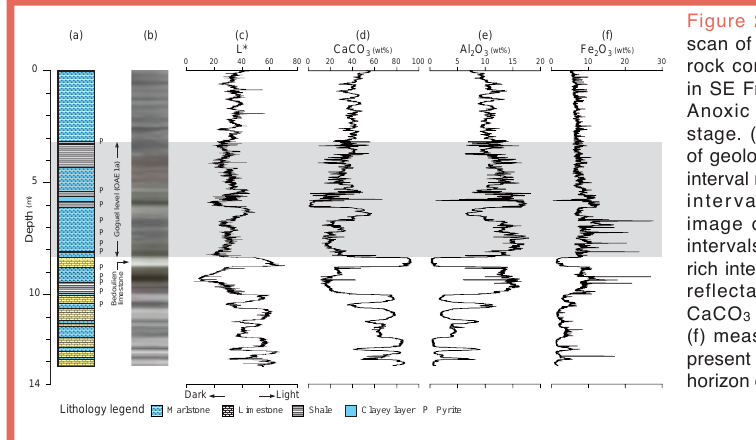
Figure 2. Example TATSCAN-F2 scan of a Cretaceous sedimentary rock core drilled at a land-section in SE France including the Ocean Anoxic Event (OAE) Ia (Goguel) stage. (a) Graphic representation of geological column. Gray-shaded interval represents OAE-Ia (Goguel) interval. (b) Gray-scale photo image of the core. Dark-colored intervals correspond with organic- rich intervals. (c) Lightness of color reflectance (L*). The contents of CaCO 3 (d), Al 2 O 3 (e), and Fe 2 O 3 (f) measured by the TATSCAN-F2 present as oxides. Gray band is the horizon of Goguel